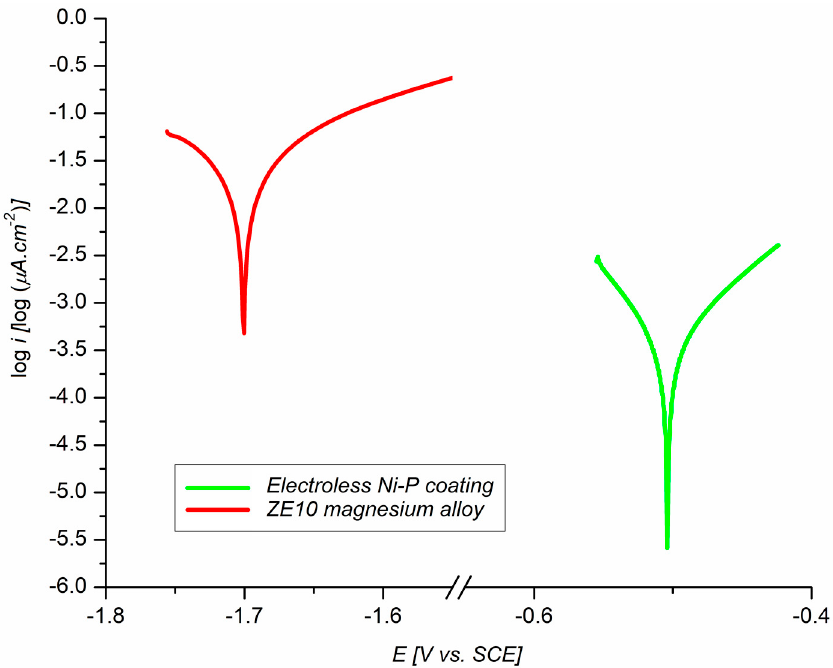
Figure 6. Characteristic potentiodynamic polarization curves for the ZE10 magnesium alloy and the ZE10 alloy with a deposited Ni–P coating in 0.1 M NaCl obtained at laboratory temperature.